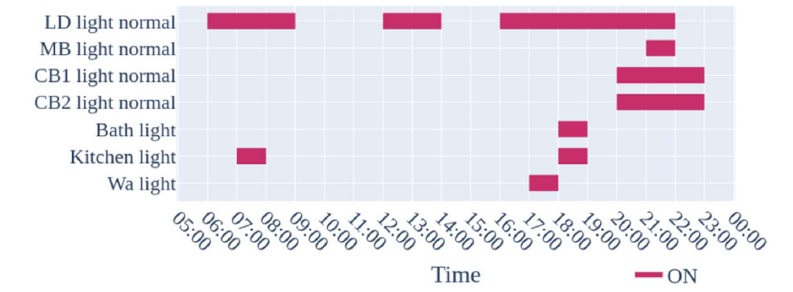
Figure 6. Lighting usage plan .